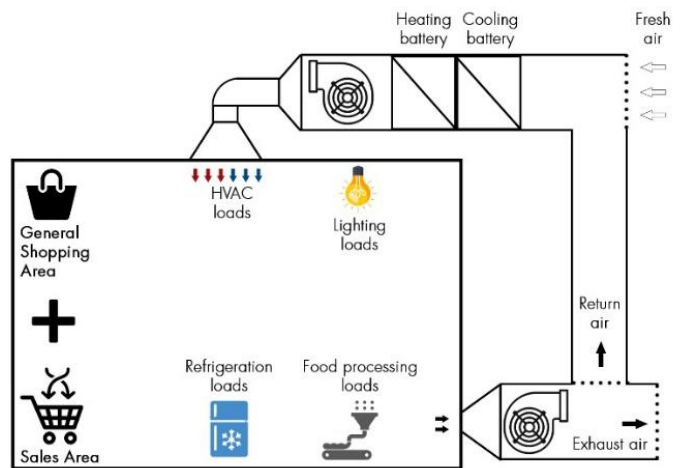
Figure 1. HVAC system operation and supermarket common loads.